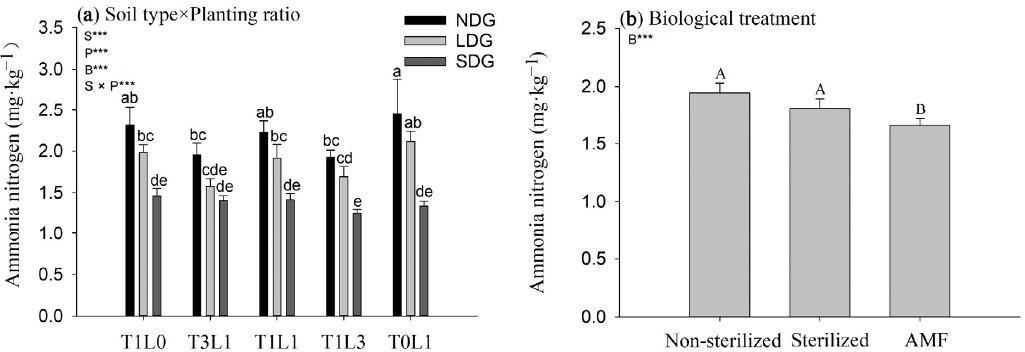
Figure 7. Effects of different treatments on soil NH 4+ -N content. ( a ) Effects of soil type (S), planting ratio (P) and their interactions (S × P) on soil ammonia nitrogen concentration. ( b ) Effects of biological treatment (B) on soil ammonia nitrogen concentration. Different capital and lowercase letters indicate significant differences between treatments. *** p < 0.001 indicate the significance level of each treatment. Note: soil degradation degree (S); planting ratio (P); soil biological treatment (B); NDG: non-degraded grassland; LDG: lightly degraded grassland; SDG: severely degraded grassland. T1L0, T3L1, T1L1, T1L3, T0L1 mean planting ratio of T. repens and L. perenne : 1:0, 3:1, 1:1, 1:3, 0:1, respectively.